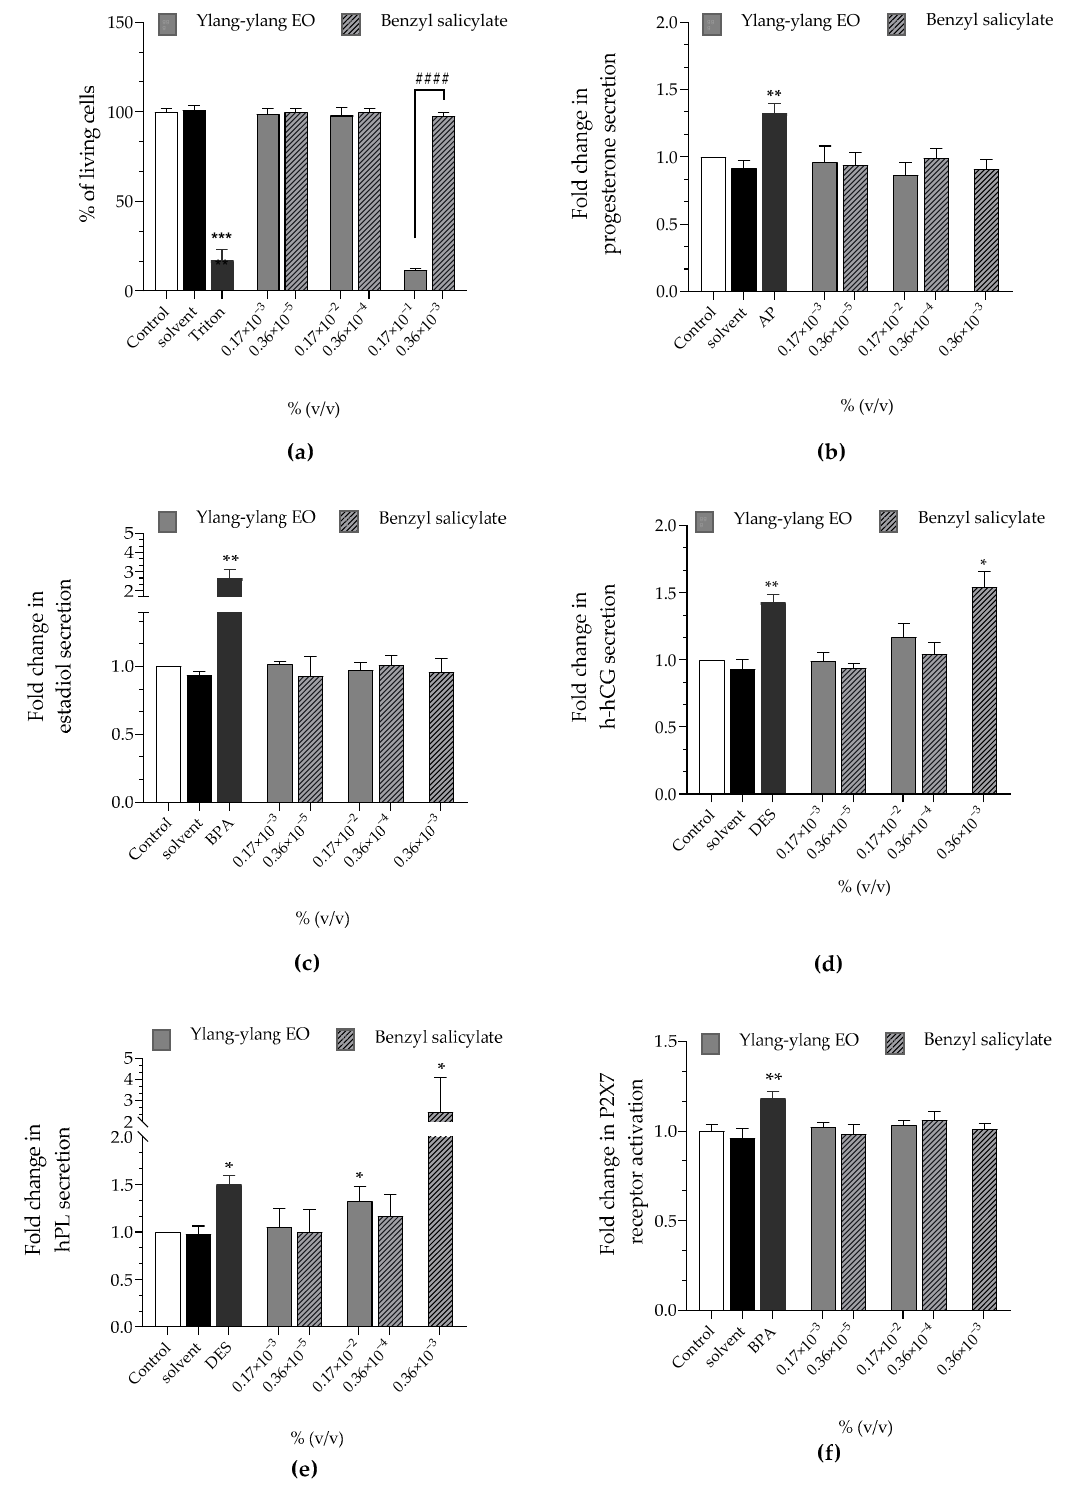
Figure 5. Effects of ylang-ylang EO and benzyl salicylate on ( a ) cell viability (Alamar Blue assay), on released hormones: ( b ) progesterone ( c ) estradiol, ( d ) h-hCG, and ( e ) hPL and on ( f ) P2X7 receptor activation (YO-PRO-1 assay) were evaluated, after incubation of JEG-Tox cells for 72 h. Triton ® X-100 at 0.016%, bisphenol A (BPA) at 20 µM, 4-tert-amylphenol (AP) at 10 µM and diethylstilbestrol (DES) at 3.75 µM are used as positive controls. The significance thresholds were * p <0.1, ** p <0.01, *** p <0,001 and #### p <0.0001.